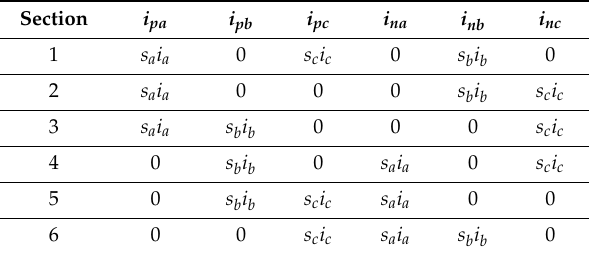
Table 1. Instantaneous values of i px and i nx .